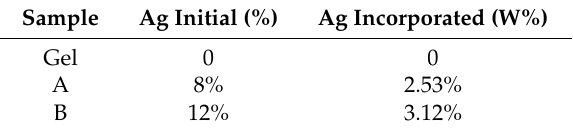
Table 1. Summary and Ag loading of the hydrogel and nanocomposites determined by ICP-OES.